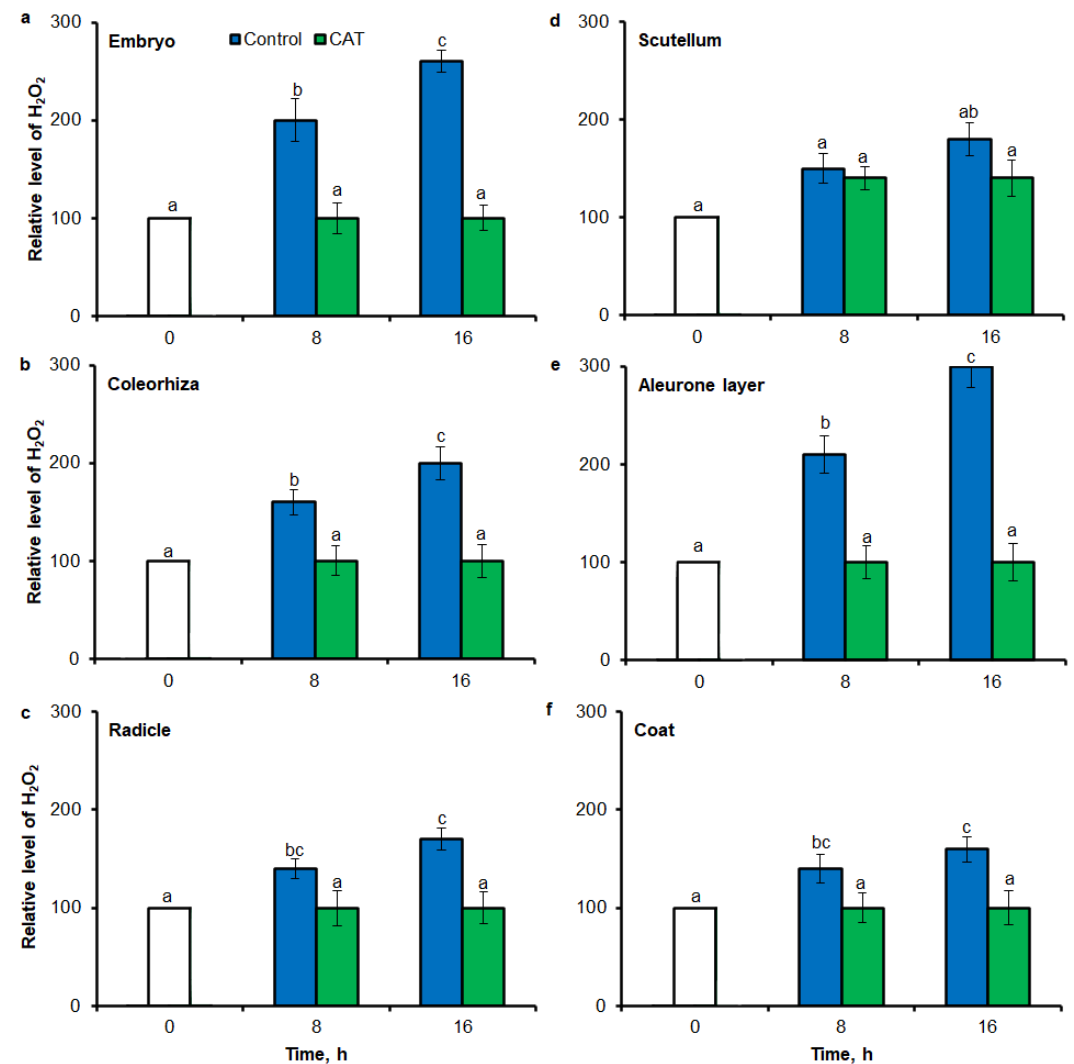
Figure 7. Quantification of H 2 O 2 in A. fatua embryo ( a ), coleorhiza ( b ), radicle ( c ), scutellum ( d ), aleurone layer ( e ) and coat ( f ) of seeds incubated in water or CAT (1000 U) at 20 °C for different time by FCM. Fluorescence data are expressed as mean fluorescence intensity (percentage of control). No autofluorescence was present when samples were incubated without dye. Vertical bars indicate ± SD. One ‐ way ANOVA with the Duncan’s post hoc test was used to determine the significance of differences. Mean values with different letters (a–c) are significantly different ( p < 0.05, n = 5).